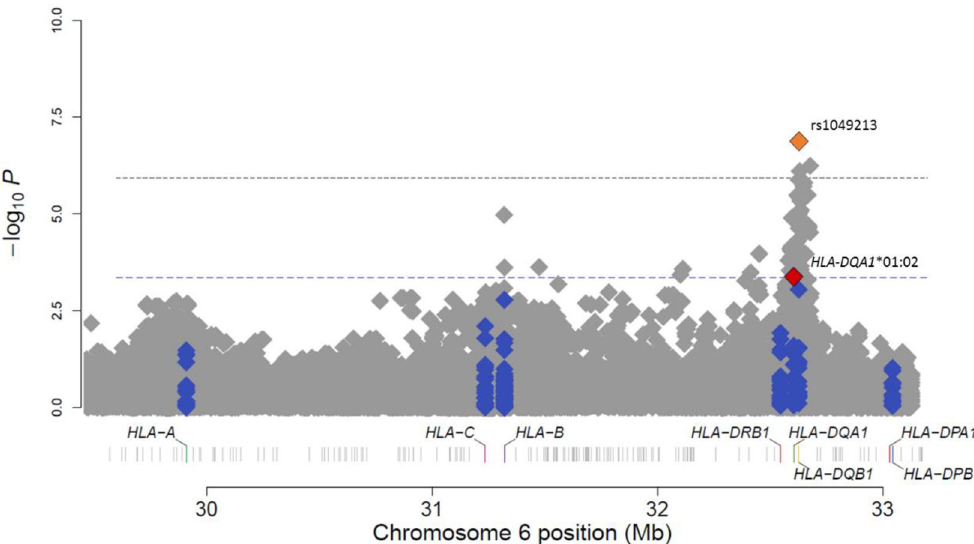
Figure 1. Manhattan plot of meta-analysis results for the association study of chromosome 6 region (grey) and the classical HLA alleles (blue). The y-axis displays transformed p -values (–log10) while the x-axis represents chromosome positions (GRCh37/hg19). The horizontal lines correspond to the significance thresholds of each study after Bonferroni correction: the upper for the targeted association ( p = 1.20 × 10 –6 ) and the lower for the classical HLA alleles mapping ( p = 4.50 × 10 –4 ). The significant variants are highlighted in orange (targeted association testing of SNPs) and red (fine mapping of classical HLA alleles). The code used to plot the data was obtained from HATK 30 .